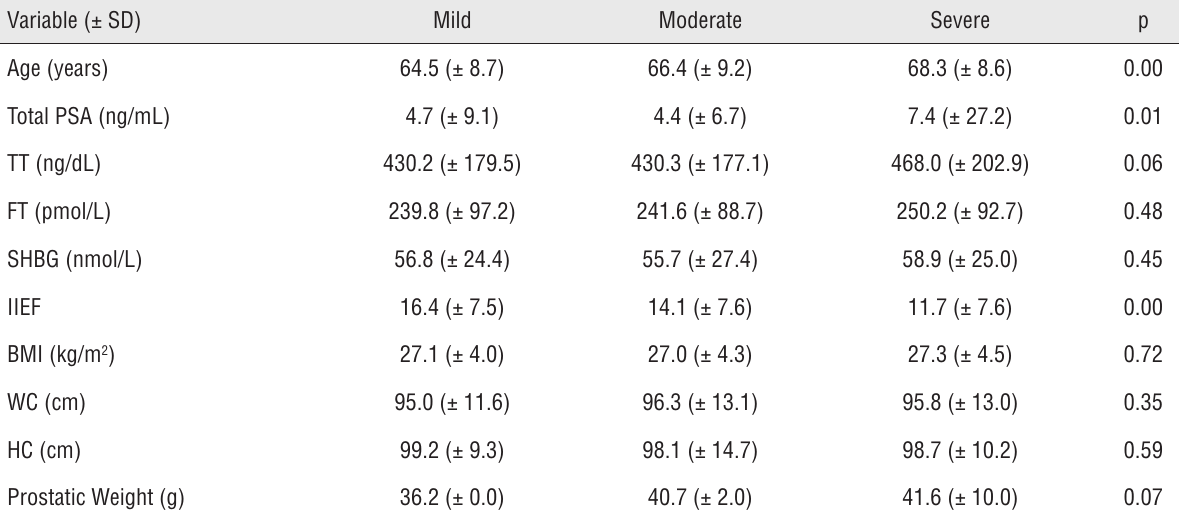
Table 2 - Correlation of AUA symptom score categories with clinical